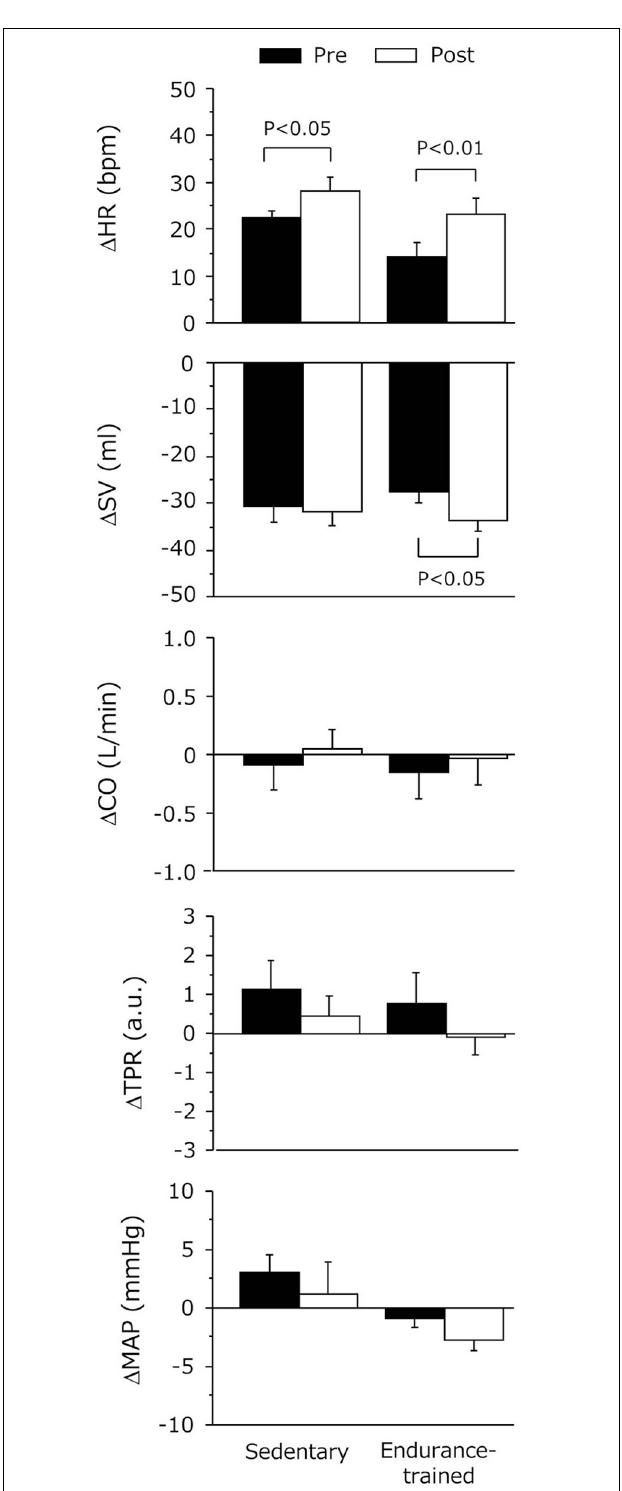
FIGURE 3 | Hemodynamic changes during 5-min orthostatic stimulation before and after the dynamic exercise bout. Data are mean and s.e.m. SV, stroke volume; HR, heart rate; CO, cardiac output; TPR, total peripheral resistance; MAP, mean arterial pressure. Delta ( (cid:2) ) indicates the difference from the baseline to sustained HUT.